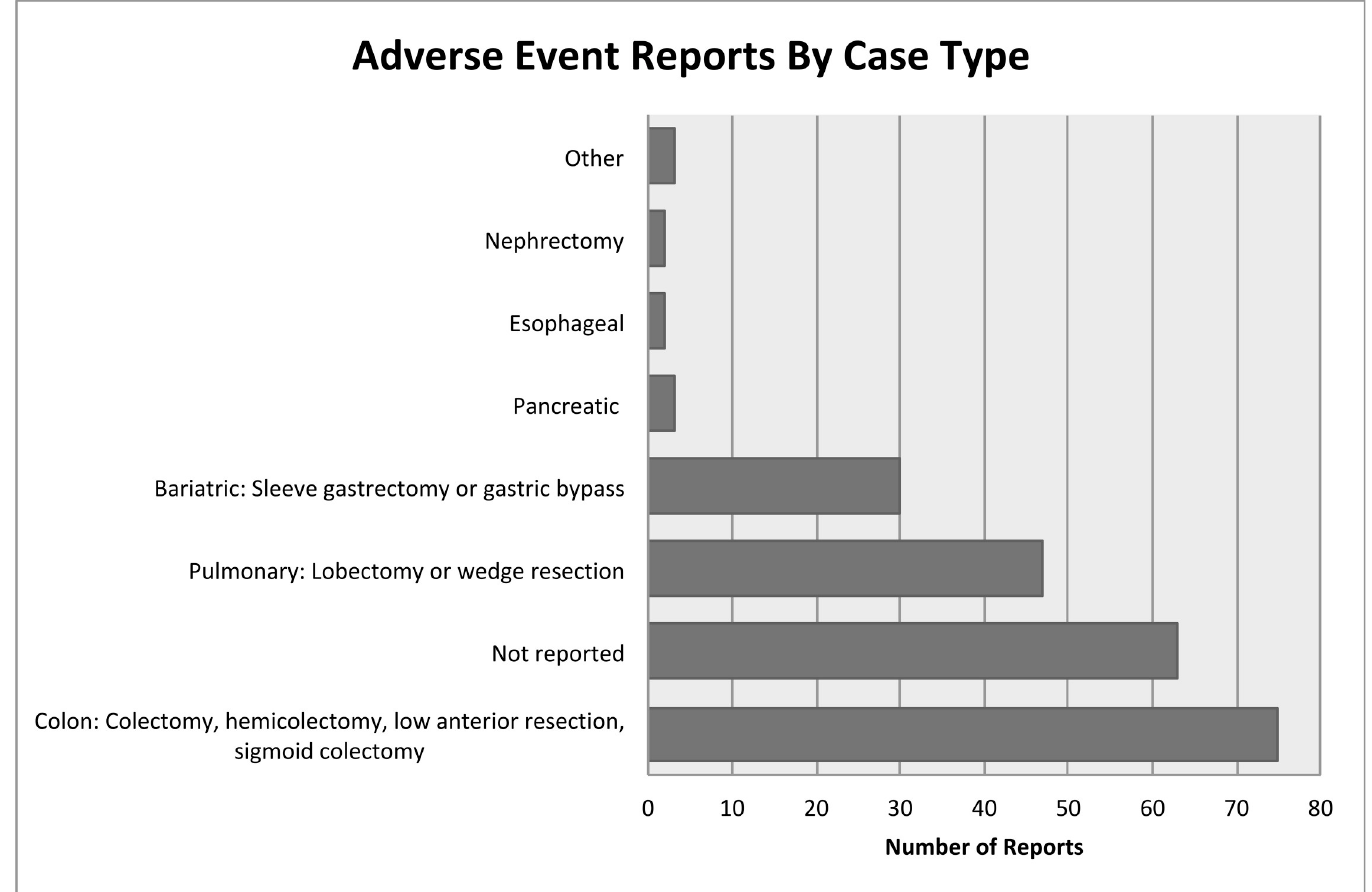
Fig 3. Summary of adverse events by case type. Colorectal procedures were most commonly associated with stapler complications (75 of 225 reports; 33.3%).